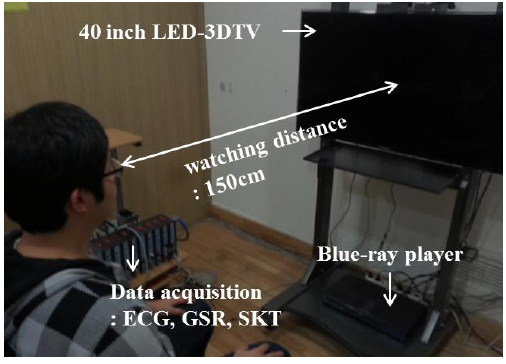
Figure 2. Picture of experimental